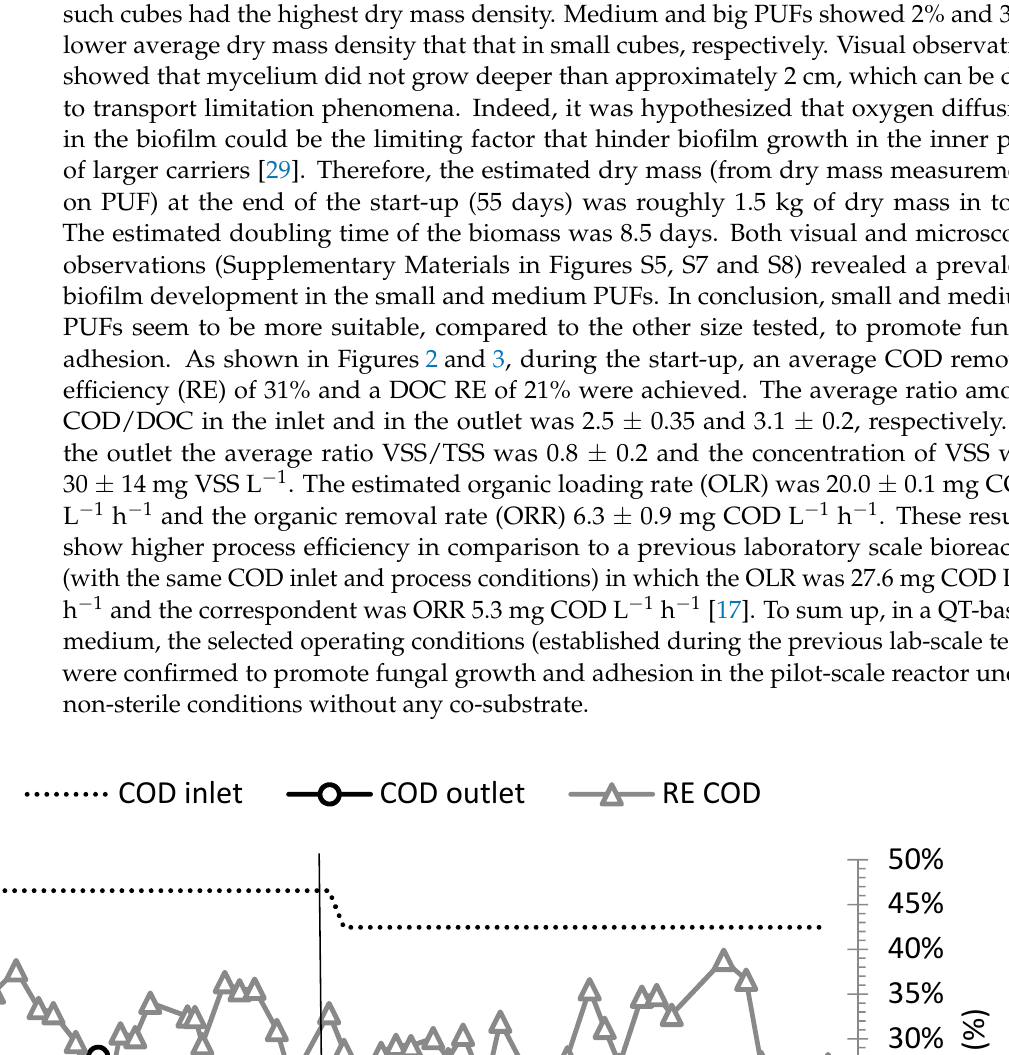
Figure 3. Inlet and outlet DOC and DOC removal percentages during continuous treatment in the pilot reactor. Different phases of the experiment are divided by vertical line. The dry mass inside small PUFs grew till 0.13 g for each PUF during the experimen- tation (day 110). In the outlet, 28 ± 14 mg of VSS L − 1 were detected. Consequently, the dry mass of biofilm of the overall reactor was estimated about 1.5 kg at the end of start-up period and 2.8 kg at the end of treatment phase. At the end of the start-up, the biomass present in the reactor was estimated to be approximately to 2.2 kg of COD. A further in- crease of 1.8 kg was quantified during the treatment phase. A COD mass balance during the entire start-up revealed that approximately 11.8 kg of COD were removed and 12.7 kg of COD were removed during the treatment phase. The biomass in the outlet was 0.7 kg as VSS in the start-up phase (approximate as 1 kg of COD) and in the treatment phase was 0.8 kg as VSS (approximate as 1.1 kg of COD). Equations (1) and (2) were employed to